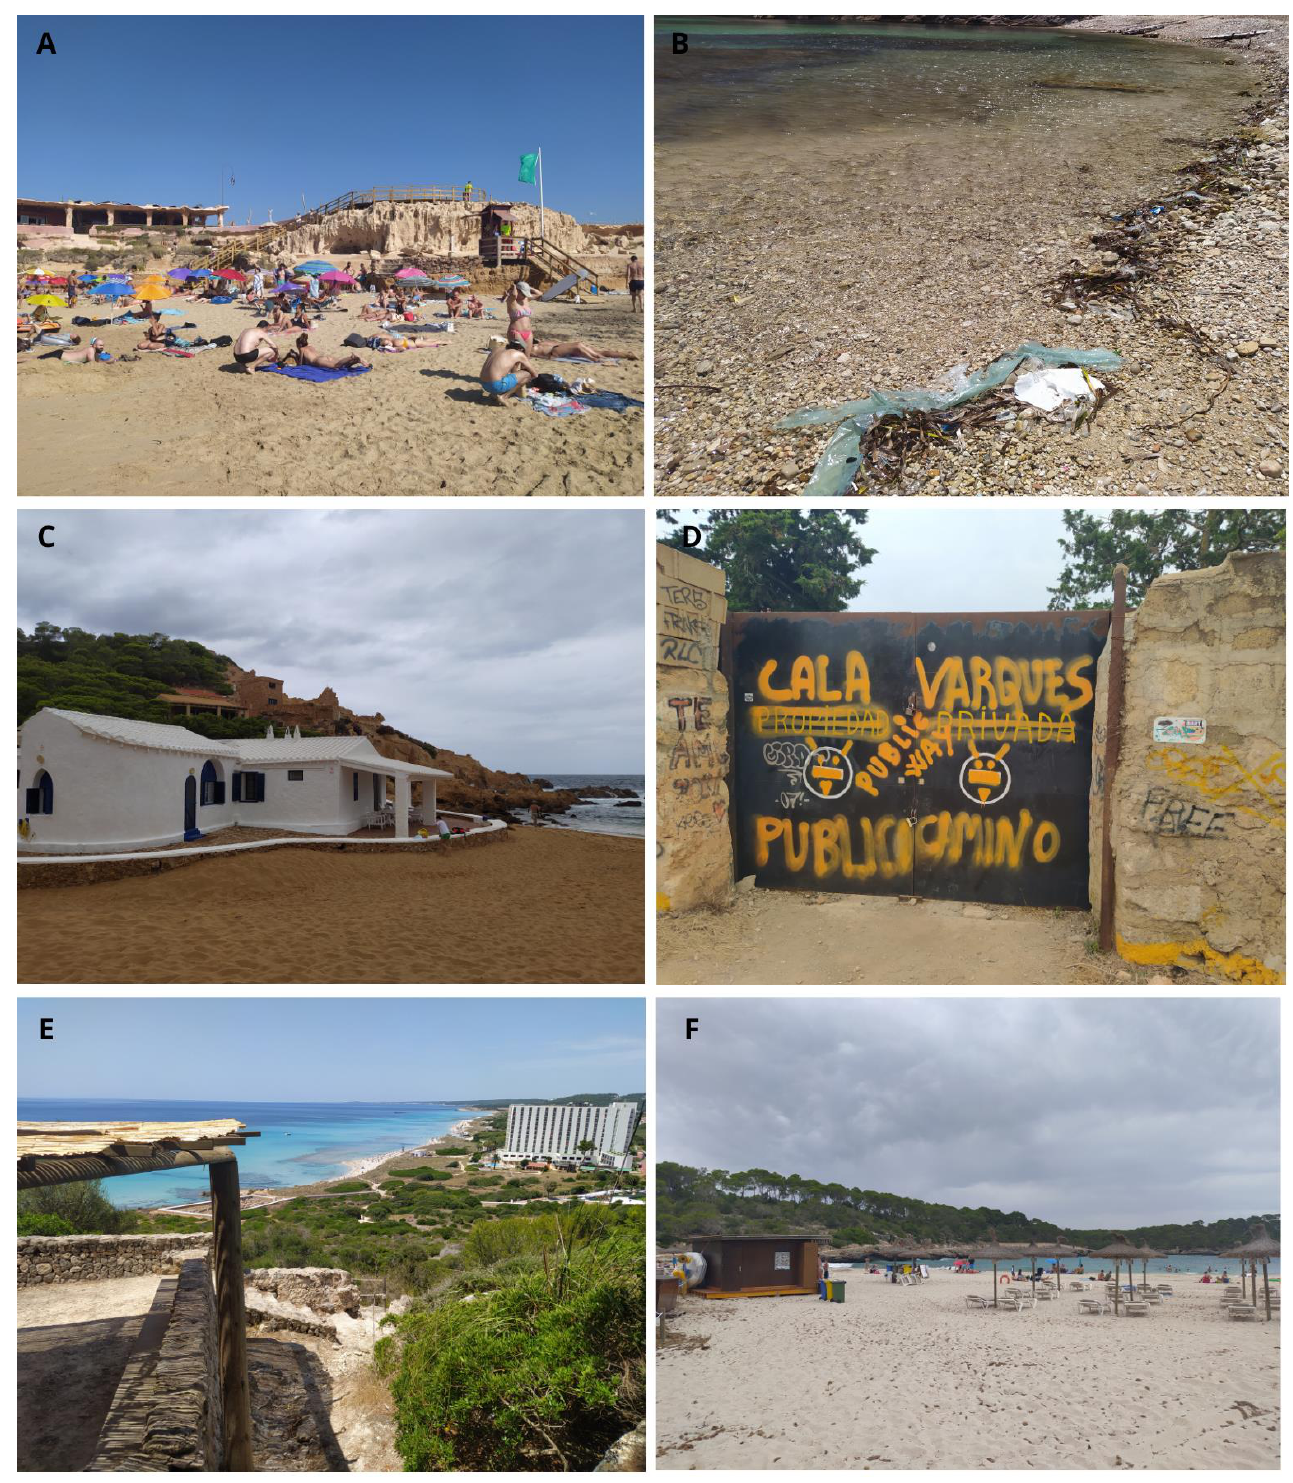
Figure 10. Examples of human scenic impacts: noise disturbance at Cala Comte, Ibiza ( A ); plastic litter stranded at Cala Llentrisca, Ibiza ( B ); the curious case of Cala Pregonda ( C ); conflicts between beach users and private coastal landowners at Cala Varques, Mallorca ( D ); skyline impact of buildings (background) at Son Bou, Menorca ( E ). Beach kiosk, suns beds, beach umbrellas and litter bins in S’Amarador, Mallorca ( F ).